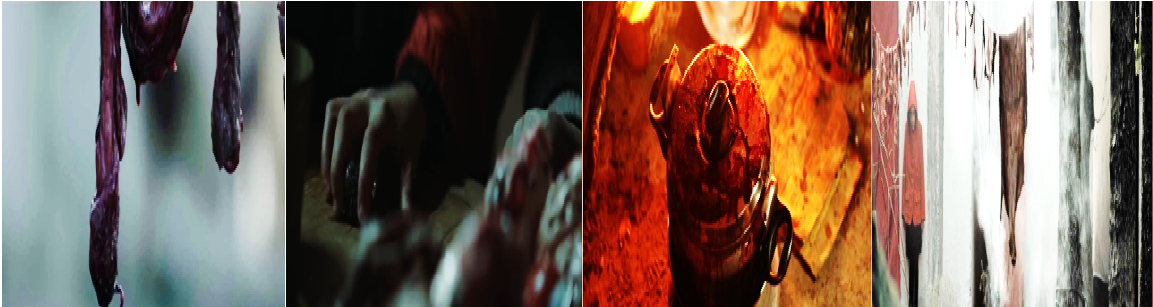
Figure 12: The dominance of the chromatics of fire, a sign of fear and